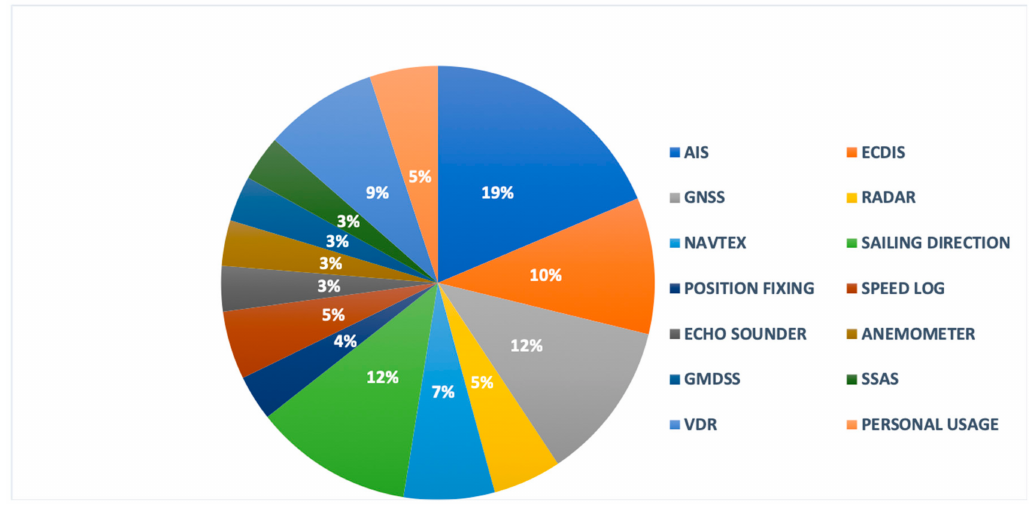
Figure 1. Composition of collected maritime vulnerability